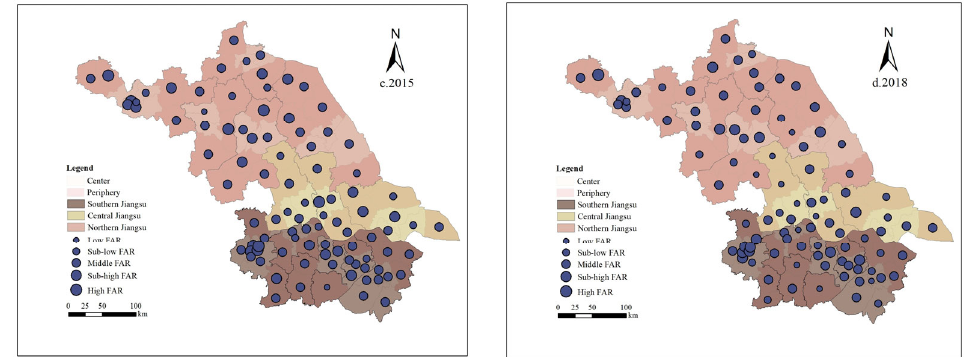
Figure 5. Spatial distribution pattern of urban vertical expansion in Jiangsu Province. (from 2009 to 2018).